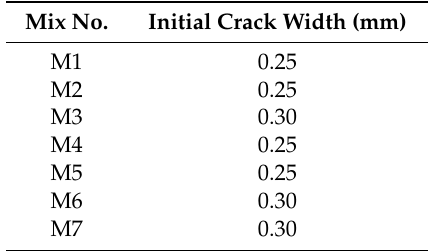
( a ) ( b ) Figure 4. ( a ) MTS; ( b ) realised cracks. Figure 4. ( a ) MTS; ( b ) realised cracks. Table 5. Initial crack widths of concrete in each Table 5. Initial crack widths of concrete in each mix.